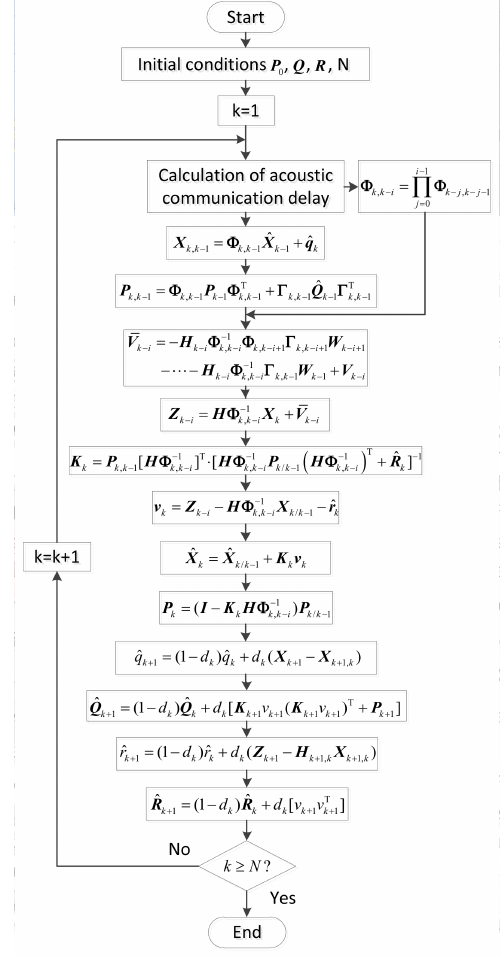
Figure 6. Flow chart of modified AKF considering acoustic communication